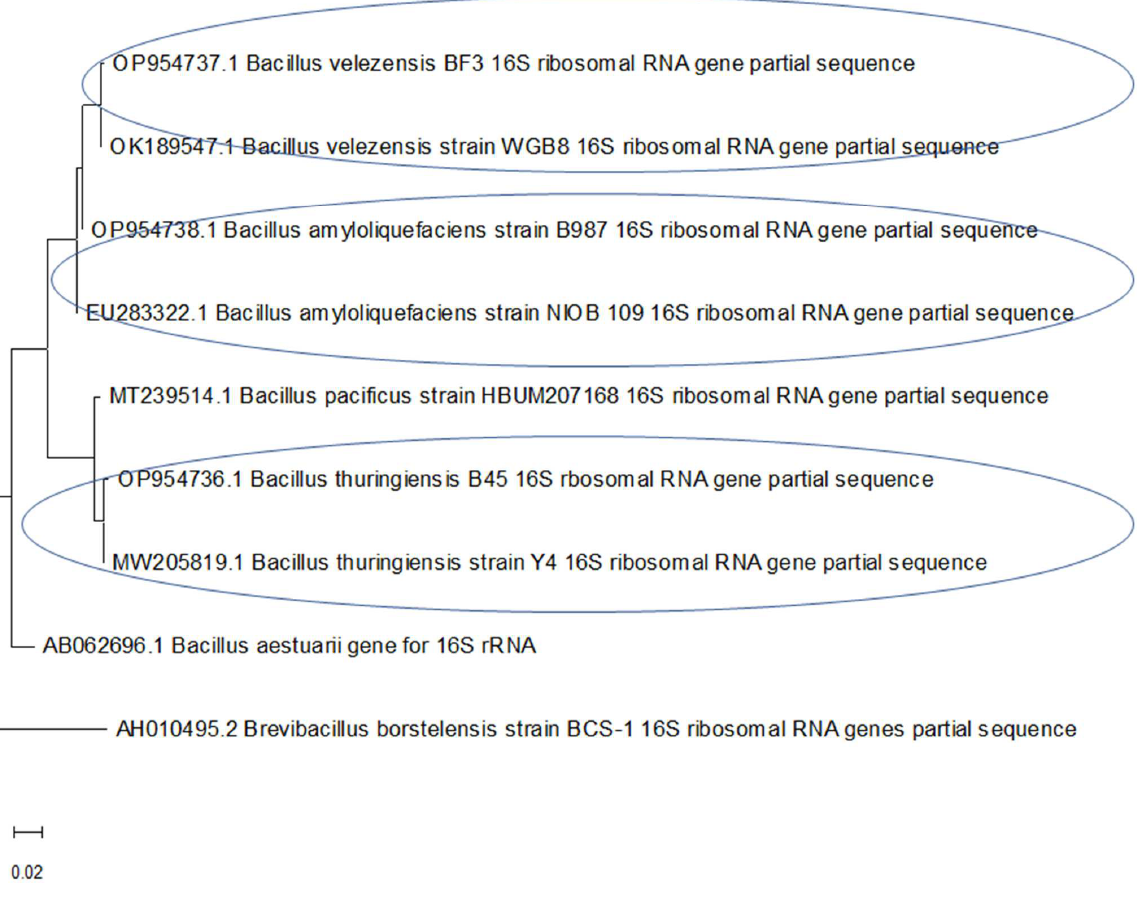
Figure 1. Phylogenetic analysis of the isolates Bacillus velezensis BF3, B. amyloliquefaciens B987 and B. thuringiensis B45.